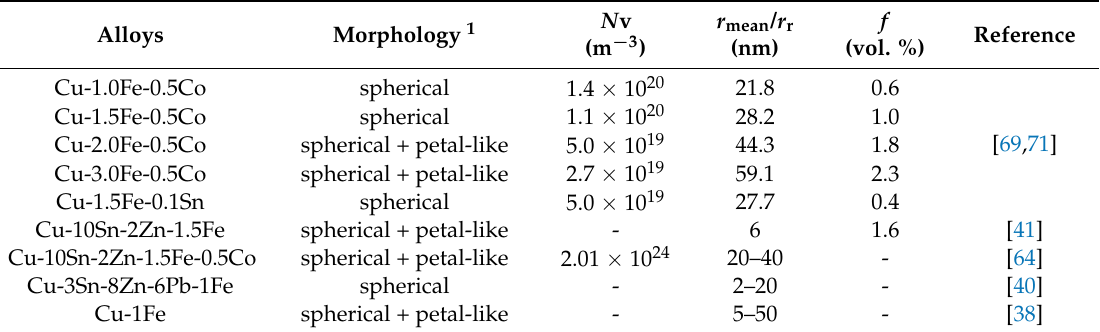
Table 2. Statistics results of number density N v, mean radius r mean (or radius range r r ), volume fraction f of spherical and petal-like nanoparticles in Cu